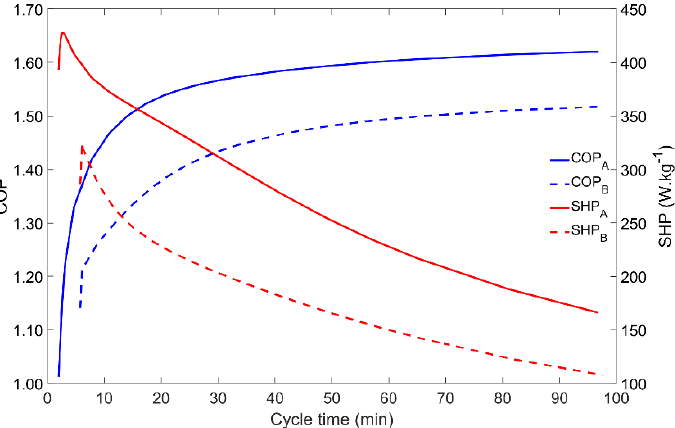
Figure 6. Influence of the cycle time on the adsorber performance for scenarios A and B.